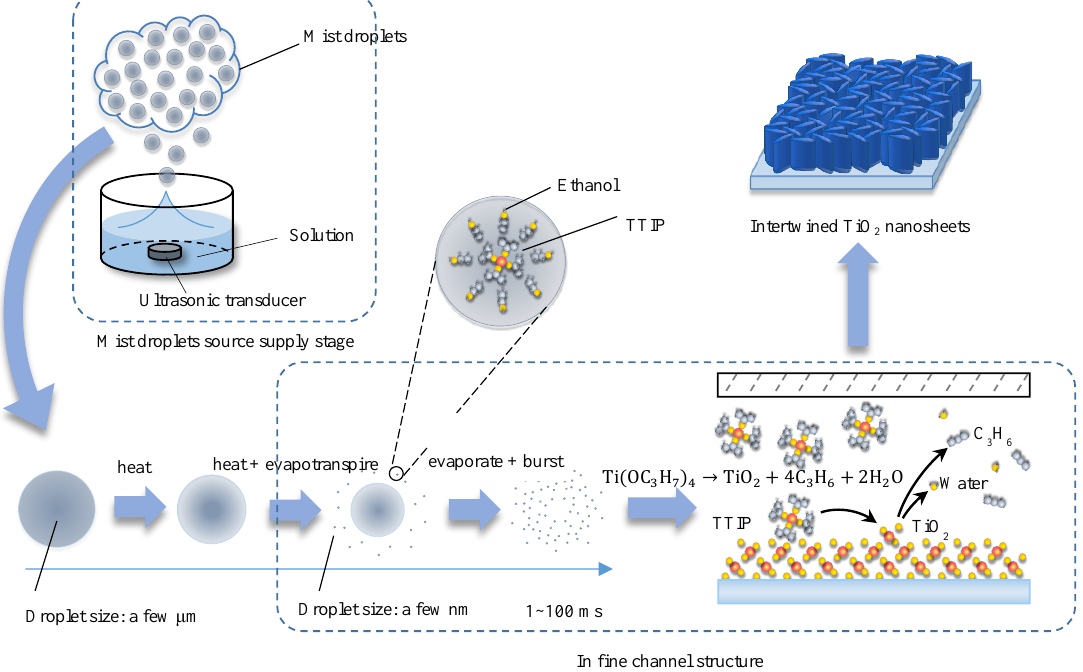
Figure 5. Mechanism of TiO 2 films deposition during the mist CVD process.